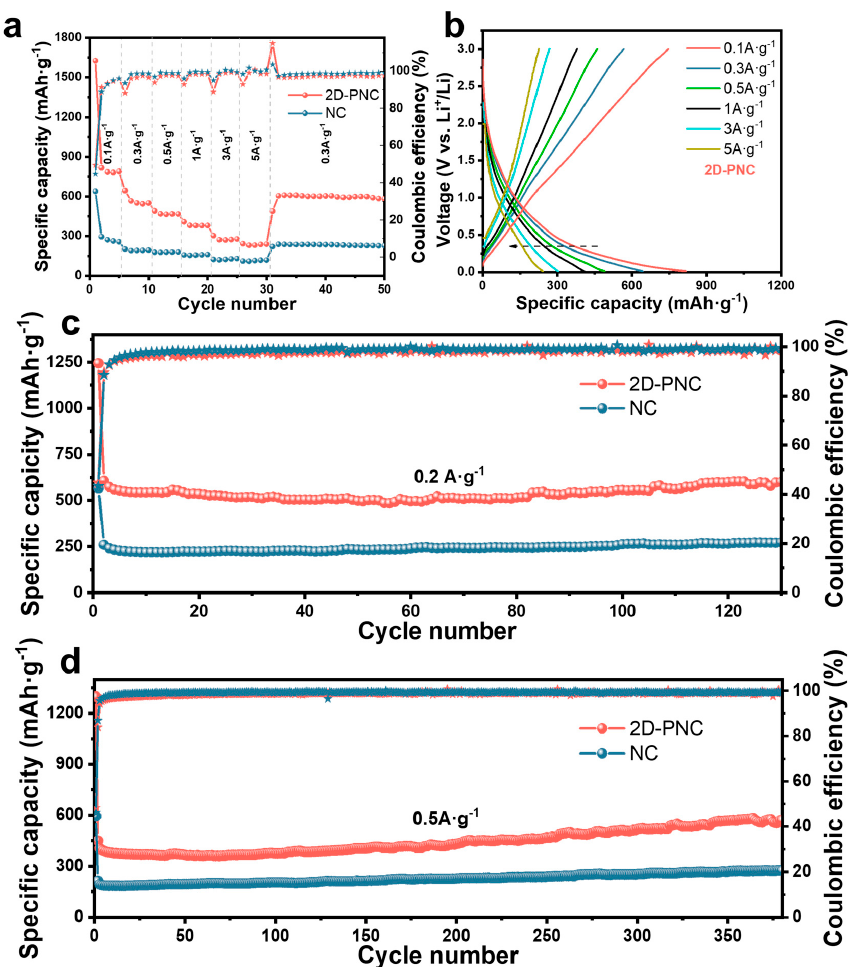
Figure 5. ( a ) Rate performances of 2D-PNC and NC and ( b ) the corresponding voltage curves at different current densities from 0.1 to 5 A g − 1 of 2D-PNC. ( c , d ) Cycling performances at 0.2 A g − 1 and 0.5 A g − 1 of 2D-PNC and NC.